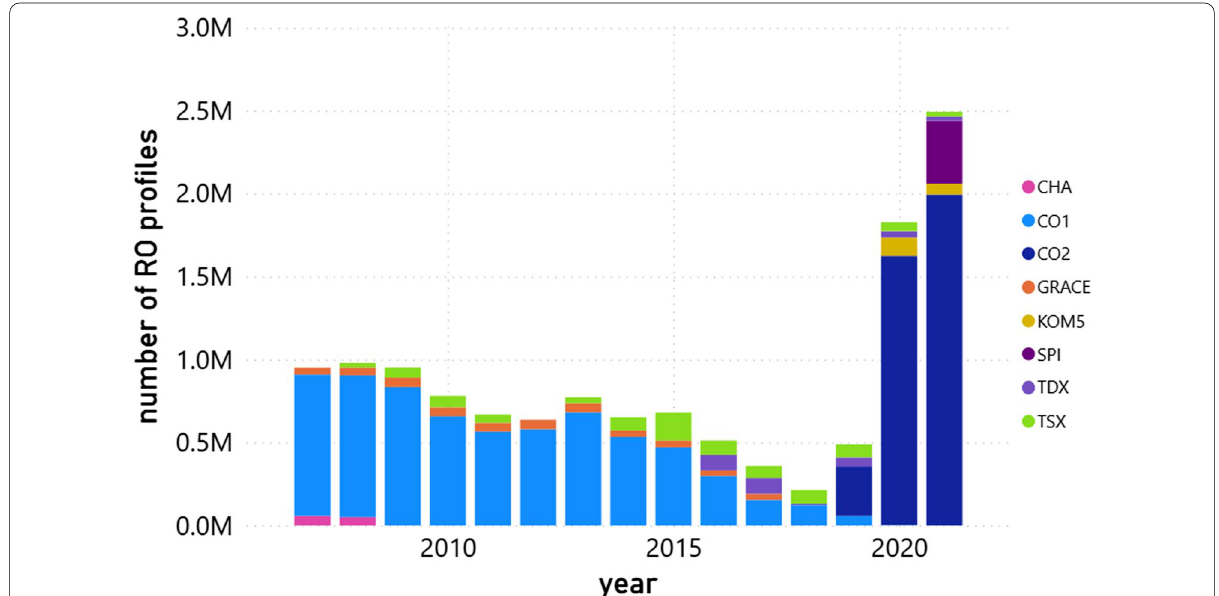
Fig. 1 Annual number of analyzed GNSS RO profiles. The different colors indicate the various satellite missions. The abbreviation CHA stands for the CHAMP satellite, SPI for Spire, KOM5 for KOMPSAT-5. CO1 and CO2 refer to the COSMIC missions and TDX and TSX stand for TANDEM-X, and TerraSAR-X,